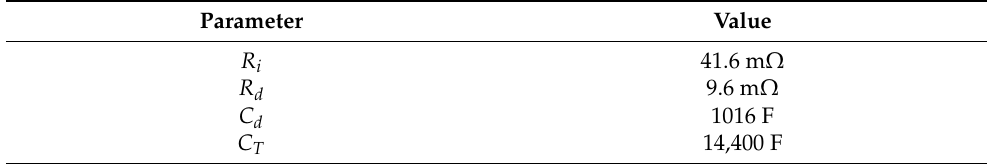
Figure 11. Voltage and current graphs obtained from the battery characterization process. The information obtained from the battery discharge test was analyzed with the process presented in [42], which performed an optimization process using nonlinear least squares to determine the values of the equivalent circuit elements shown in Table 2. Table 2. Equivalent circuit parameters of the used battery.